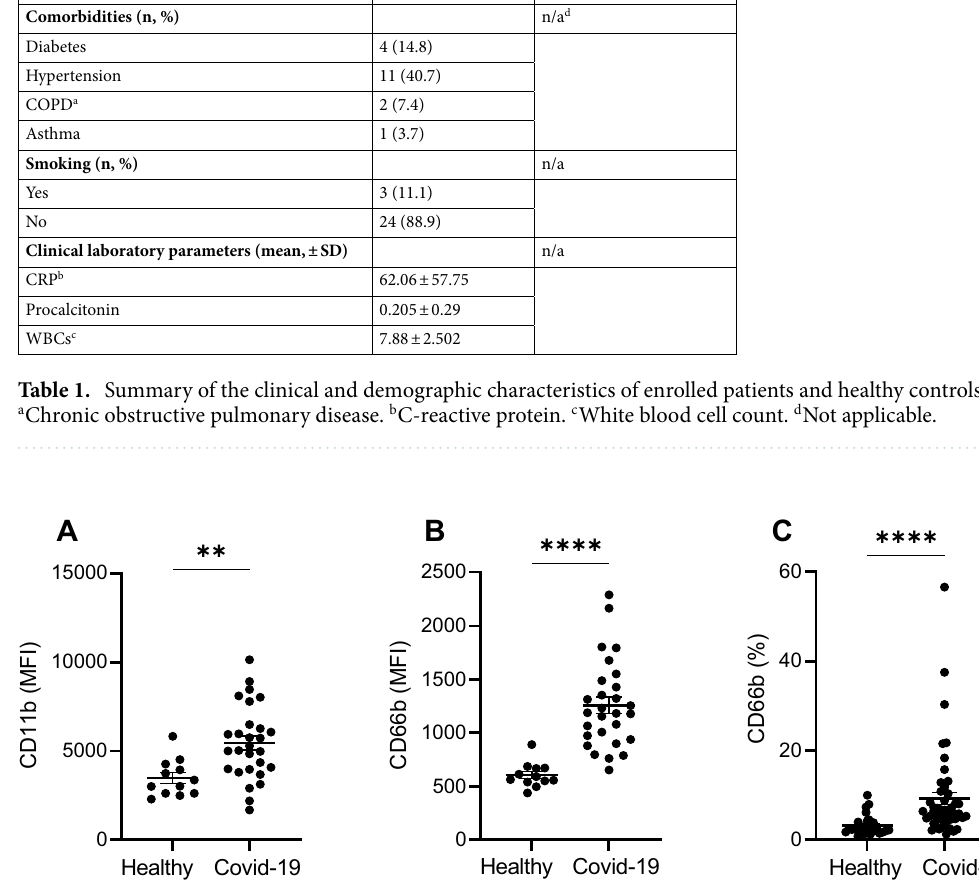
Figure 1. Expression of neutrophil activation markers seen during COVID-19. MFI is significantly increased in COVID-19 patients for CD11b ( A ) and CD66b ( B ). A significantly higher percentage of neutrophils in COVID- 19 express on its surface CD66b ( C